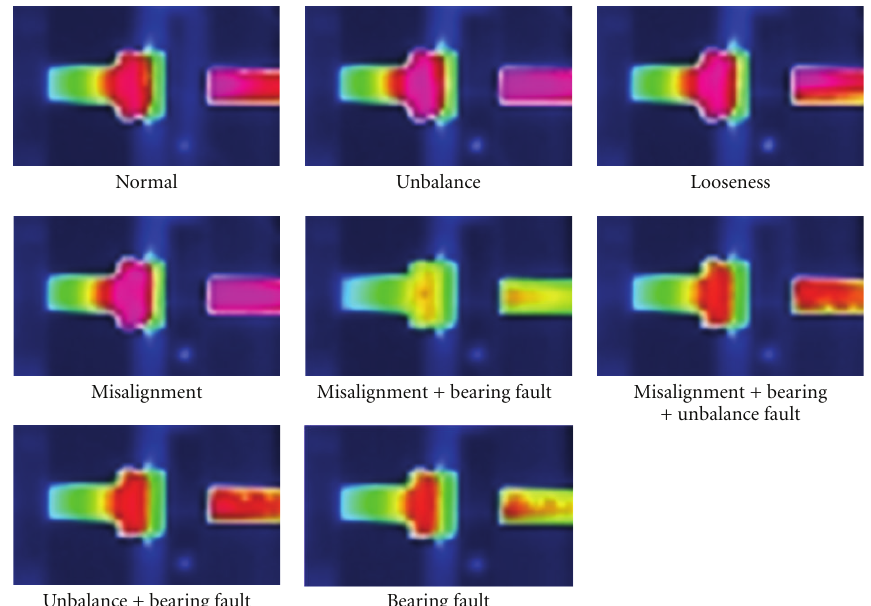
Figure 7: Thermal images of right bearing.